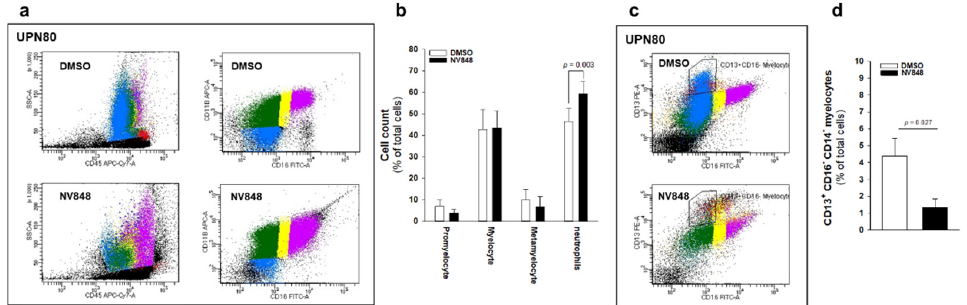
Figure 4. NV848 improves neutrophil maturation in BM-MNC isolated from SDS patients. BM- MNC from a cohort of 6 SDS patients were isolated, and cells were incubated in IMDM medium supplemented with 20 ng/mL G-CSF in the presence of NV848 (10 μ M) or vehicle alone (DMSO). ( a ), Representative experiment (UPN80) of neutrophil differentiation, as evaluated by flow cytometry by quantifying the expression of CD16 versus CD11b myeloid markers. Promyelocytes (blue spots), myelocytes (green spots), metamyelocytes (yellow spots), and neutrophils (purple spots) were counted. Red spots represent CD14 + cells. ( b ), Histogram representing data collected in panel ( a ); data are Mean ± SEM of six independent experiments conducted on BM-MNC obtained from 6 different SDS patients. ( c ), Representative experiment (UPN80) of neutrophil differentiation, as evaluated by flow cytometry by quantifying the expression of CD16 versus CD13 markers. ( d ), CD13 + CD16 − CD14 − cells (immature neutrophils) were counted in both the experimental conditions described in a; data are mean ± SEM of six independent experiments conducted on BM-MNC obtained from 6 different SDS patients. Student’s t-test for paired data has been calculated and indicated within the histograms.